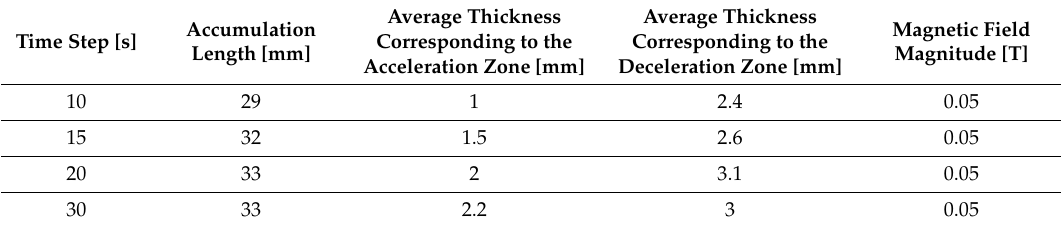
Table 6. Characteristics of the particle accumulation shape during the injection time along the host’s arterial wall.